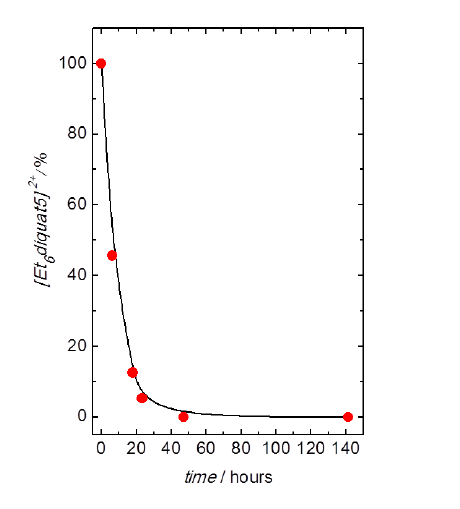
Figure 8. Kinetics of Et 2+ decomposi- 6 -diquat-5 tion at 160 °C. Initial concentration of Et 6 - diquat-5 Br 2 c 0 SDA = 0.168 mol dm − 3 , initial concentration of NaOH c 0 SDA = 1.66 mol dm − 3 , solvent deionized water.